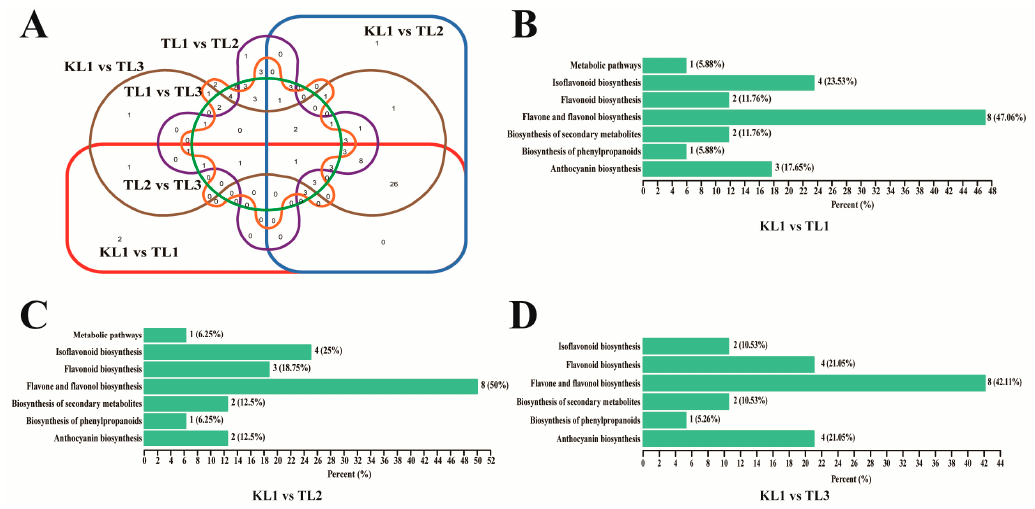
Figure 5. Venn diagram of differential flavonoid metabolites for each comparison group and KEGG classification results. ( A ) Venn diagram showed the overlapping and unique differential metabolites amongst the comparison groups. Circles with different shapes and different colors of red, blue, brown, purple, orange, and green represented different comparison groups of KL1 vs. TL1, KL1 vs. TL2, KL1 vs. TL3, TL1 vs. TL2, TL1 vs. TL3, and TL2 vs. TL3, respectively. ( B – D ) The differential metabolites KEGG classification of the comparison group KL1 vs. TL1, KL1 vs. TL2, and KL1 vs. TL3, respectively.